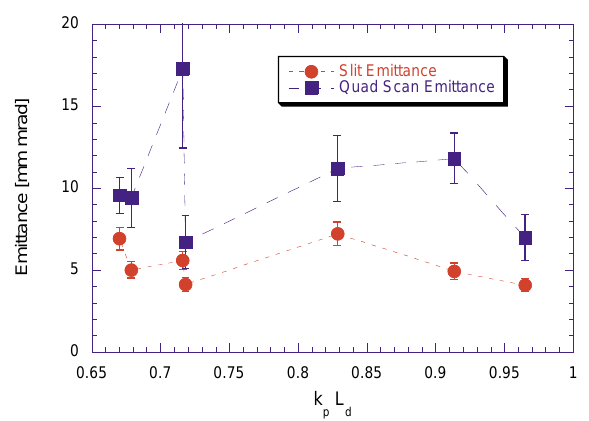
FIG. 6. (Color) Plot comparing the different emittance measure- ment techniques for varying beam intensities. The strength of the space-charge forces is parameterized in the scan by the prod- uct of the drift length between the quadrupole and detector and the plasma wave number at the quad.